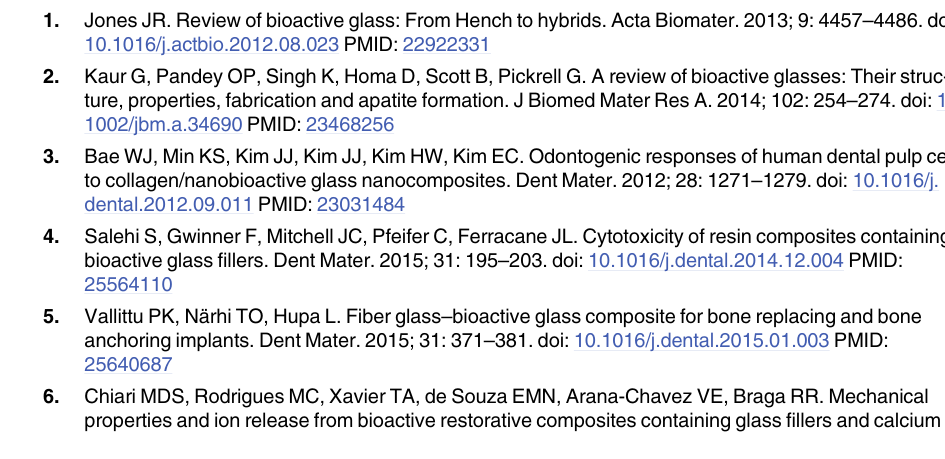
Figure A. Results of Brunauer – Emmett – Teller analysis showing typical mesoporous N tion – desorption curve. Figure B. Uptake of FITC-labeled MBNs-NH with or without pre-treatment using various types of inhibitors or culture conditions. Incubation at 4°C for 4 hours was used to prevent ATP-dependent endocytosis. ( a ) Uptake as characterized by flow cytometry according to incubation time. ( b-g ) Uptake as characterized by flow cytometry according to pre-treatment condition (1 hour). Pre-treatments included 100 mM of sodium azide (SA), inhibitor of ATP-dependent endocytosis; 2.5 mM of 5-(N-ethyl-N-isopropyl) amiloride (AE), inhibitor of macropinocytosis; 1 mM of amantadine-HCl (AT), inhibitor of clathrin-medi- ated endocytosis; and 100 mM of genistein (GE), inhibitor of caveolae-mediated